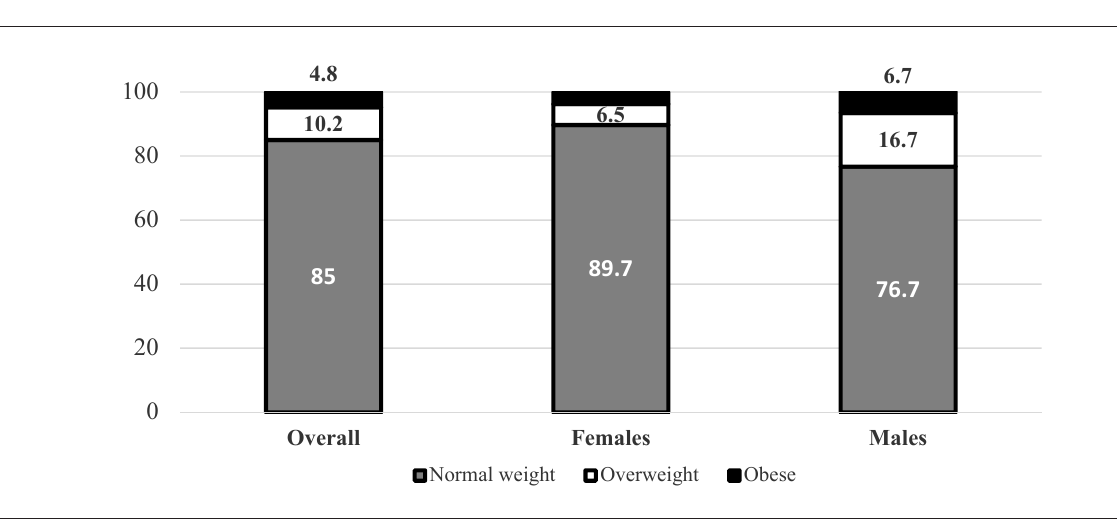
Table 1. Newest Vital Sign (NVS) score distribution by gender, class rank, ISO-BMI and